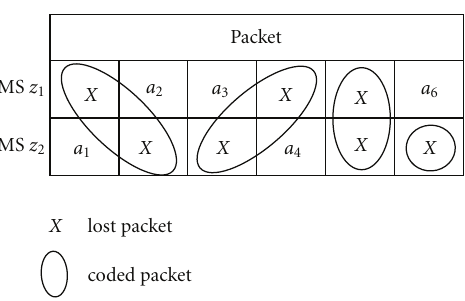
Figure 2: An example of a pattern of lost packets at MSs z 1 and z 2